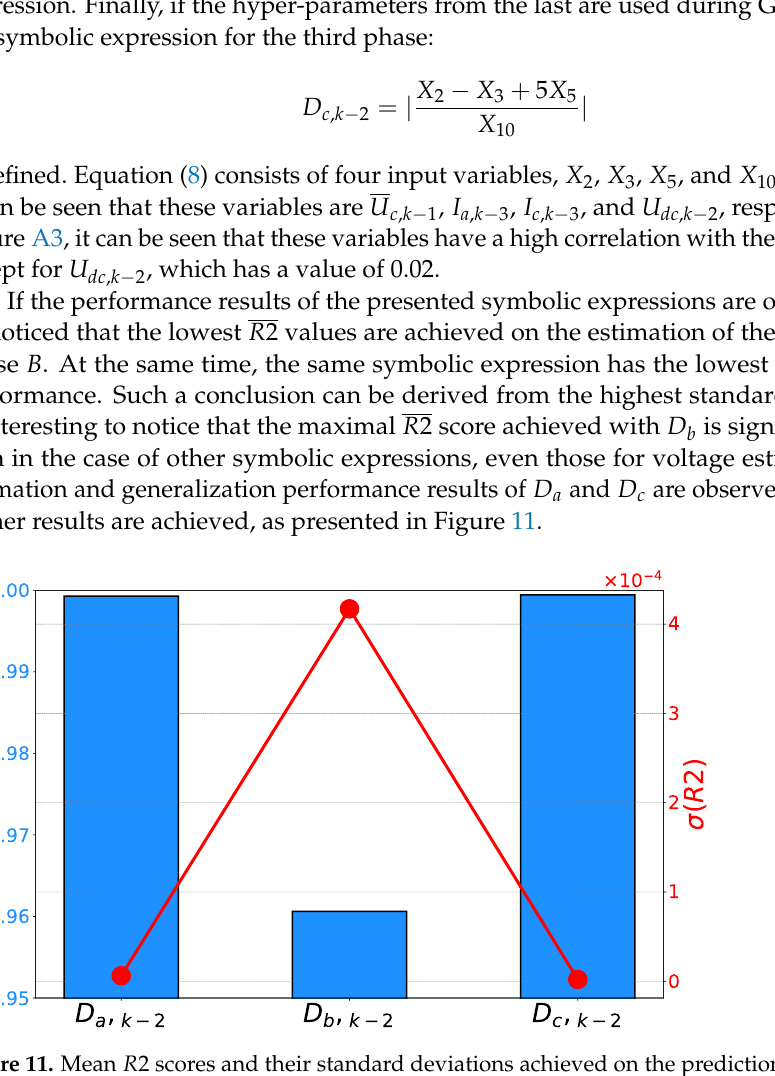
Figure 11. Mean R 2 scores and their standard deviations achieved on the prediction of duty